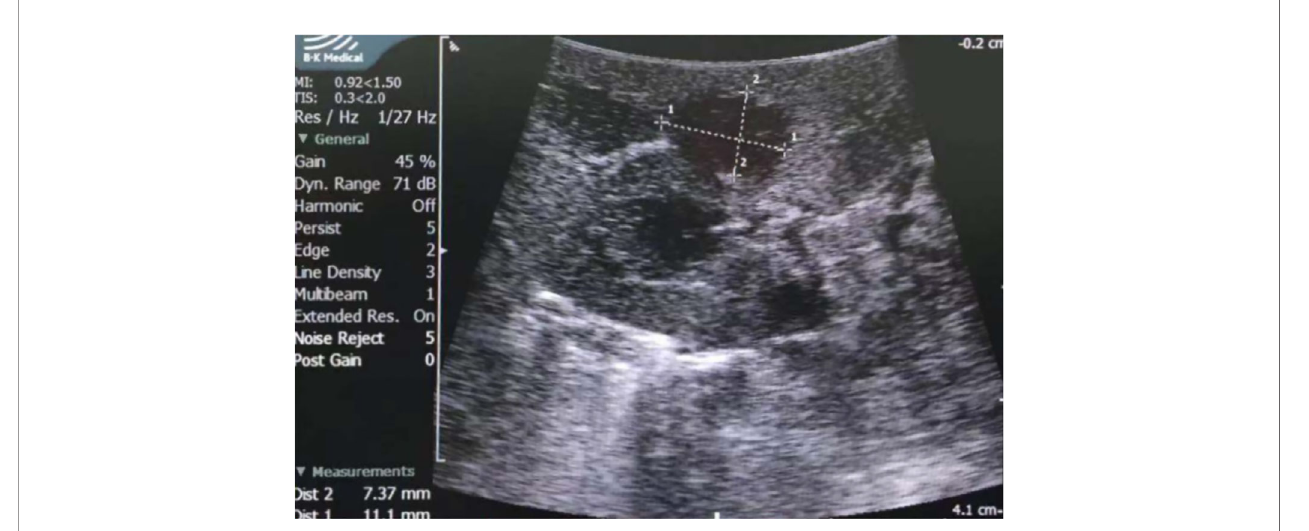
FIGURE 4 | Laparoscopic ultrasound of Patient No. 8. The tumor was hypoechoic and was measured 7.4×11.1mm by